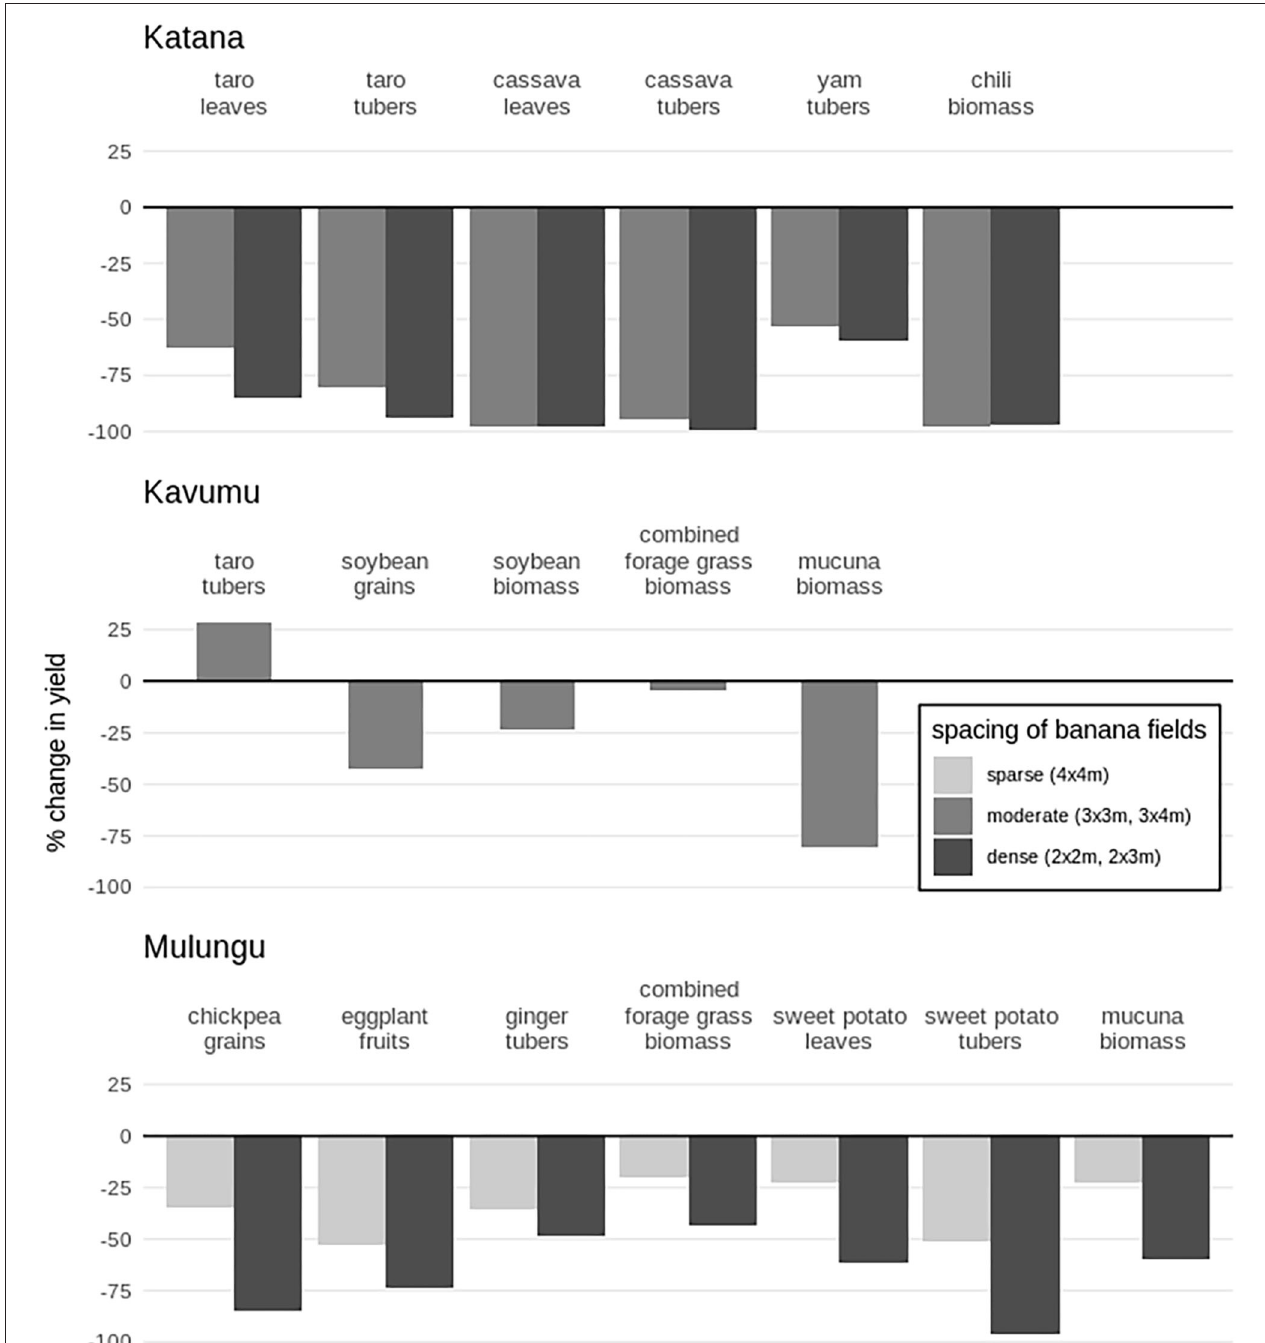
FIGURE 2 | Overview of percentage change in yield for various crops grown as intercrops in banana fields vs. as monocrop. Negative values represent a reduction in yield compared to the monocrop, positive values show an increase. Intercrops are grouped according to the spacing density of the banana field, with 4 × 4m as sparsely spaced banana fields, 3 × 3m and 3 × 4m as moderate, and 2 × 3m and 2 × 2m as densely spaced banana fields. (mean of 0.7 ± 0.5 t/ha) and the 3 × 4 m banana intercropped (mean of 0.08 ± 0.01 t/ha)